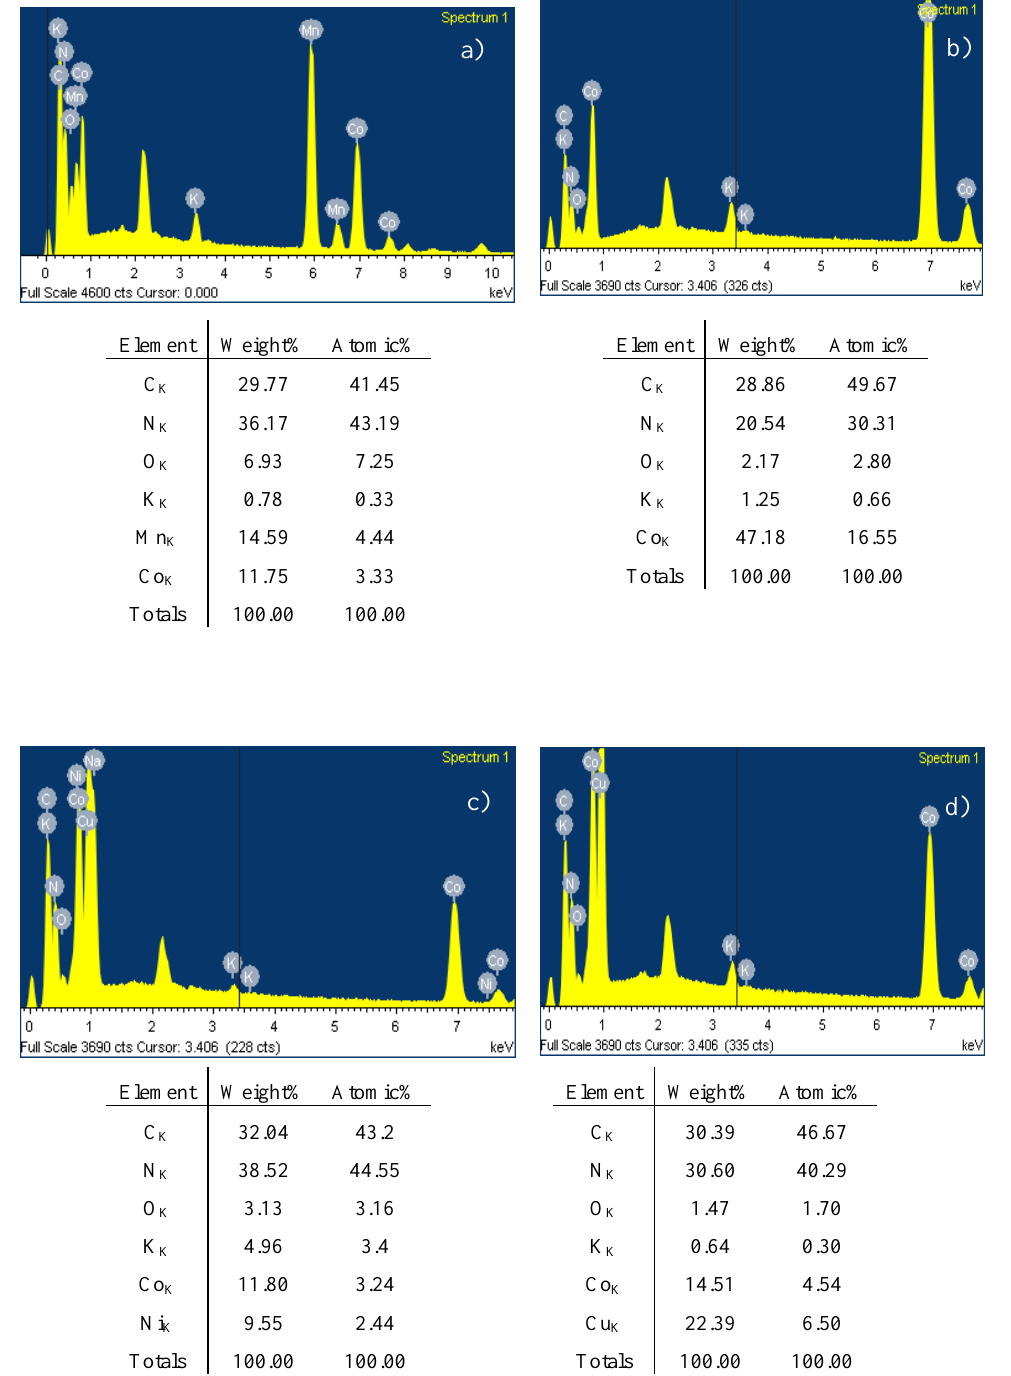
Figure 4. Images of ( a ) Mn–Co, ( b ) Co–Co, ( c ) Ni–Co, and ( d ) Cu–Co samples. Peak at 2.15 keV corresponds to Au, used in pre-treatment of measurement.